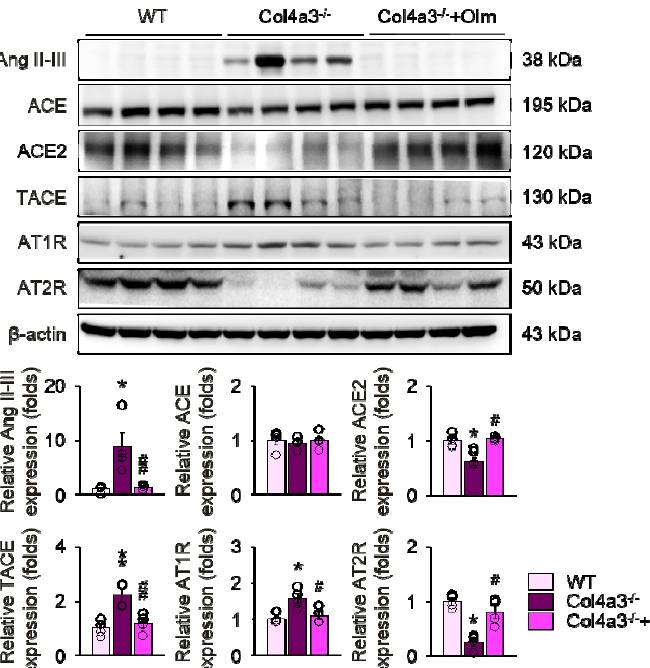
Figure 3. RAS activation in Col4a3 – / – mice is counteracted by olmesartan. Comparison of protein expression level of RAS components determined by immunoblotting from the kidney of WT, Col4a3 – / – , and Col4a3 - / - + Olm mice ( n = 4 mice / group). β -actin was used as the endogenous control. * P < 0.05, ** P < 0.01 versus WT mice; # P < 0.05, ## P < 0.01 vs. Col4a3 – / – mice by one-way ANOVA with Newman–Keuls multiple comparison test.